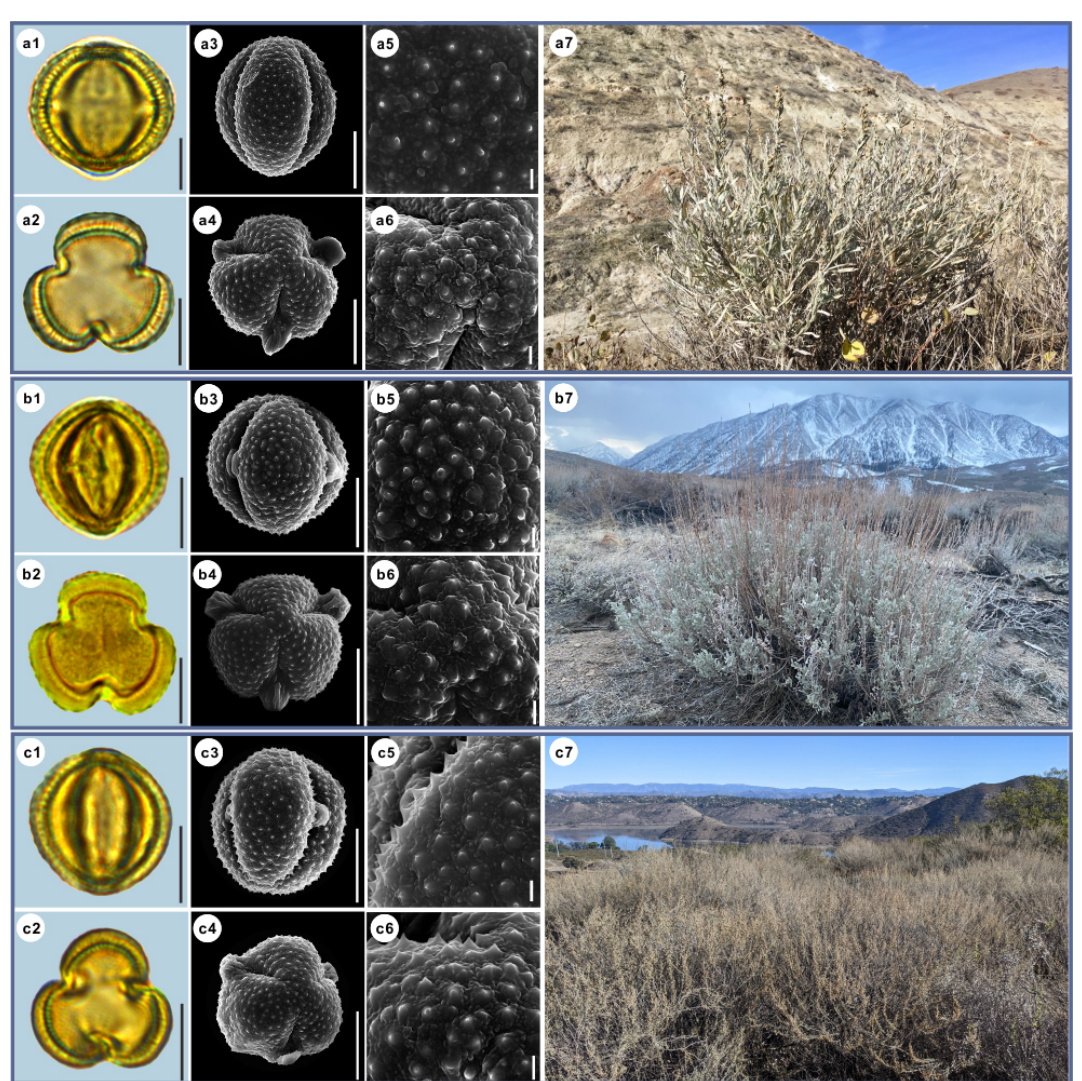
Figure 3. Pollen grains and the habitats of their source plants. (a) Artemisia cana ; (b) Artemisia tridentata ; and (c) Artemisia californica . Pollen grains in equatorial view under LM (a1, b1, c1) and SEM (a3, a5, b3, b5, c3, c5) , in polar view under LM (a2, b2, c2) and SEM (a4, a6, b4, b6, c4, c6) , along with the habitats of their source plants (a7 cited from https://www.inaturalist.org/photos/54492753, last access: 19 August 2022, by © Jason Headley, b7 cited from https://www.inaturalist.org/photos/117436654, last access: 19 August 2022, by © Matt Berger, c7 cited from https://www.inaturalist.org/photos/108921528, last access: 19 August 2022, by © Don Rideout ) . Scale bar in LM and SEM overview 10µm, and in SEM close-up